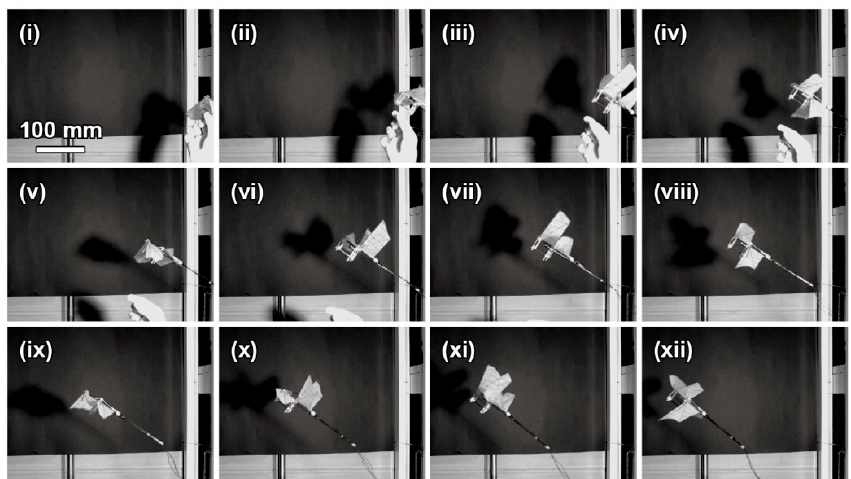
Figure 7. High-speed camera images of the ornithopter during free-flight with the gear position set at 30° with negative rotation and a measured phase angle of 271°. The time interval is 20 ms.